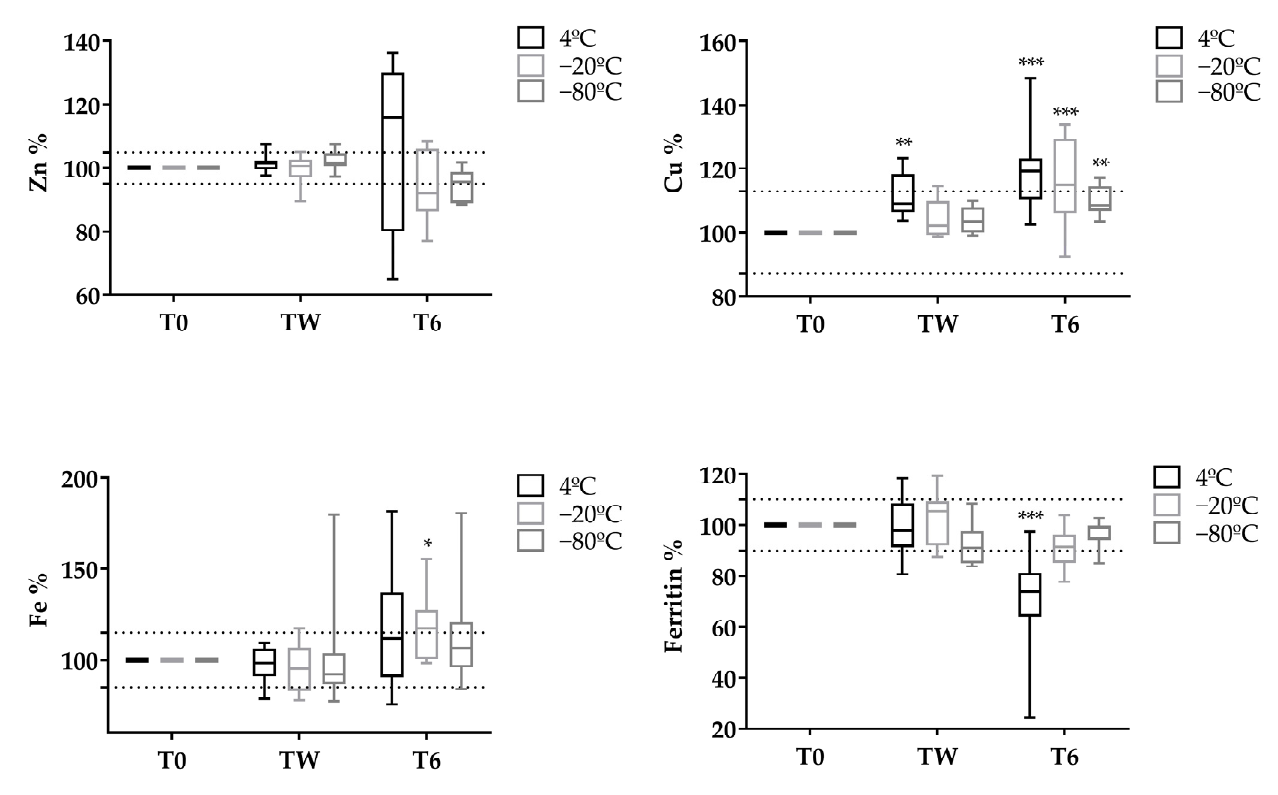
Figure 3. Stability plots of the zinc (Zn), copper (Cu), iron (Fe) and ferritin in ten porcine saliva samples kept at different temperatures. Results are expressed in percentages of the baseline concen- tration (fresh sample = 100% concentration). Each aliquot was stored at different temperatures and measured in fresh conditions (T0) and after 1 week (TW) and 6 months (T6). Dotted lines indicate the significant change limit (SCL) acceptable for the assay, which was defined as SCL = 100% ± 2 × Intra-CV. The plot shows median (line within box), 25th and 75th percentiles (box), 5th and 95th percentiles (whisker). Asterisks indicate significant differences from T0 (*: p < 0.05; **: p < 0.01; ***: p < 0.001).